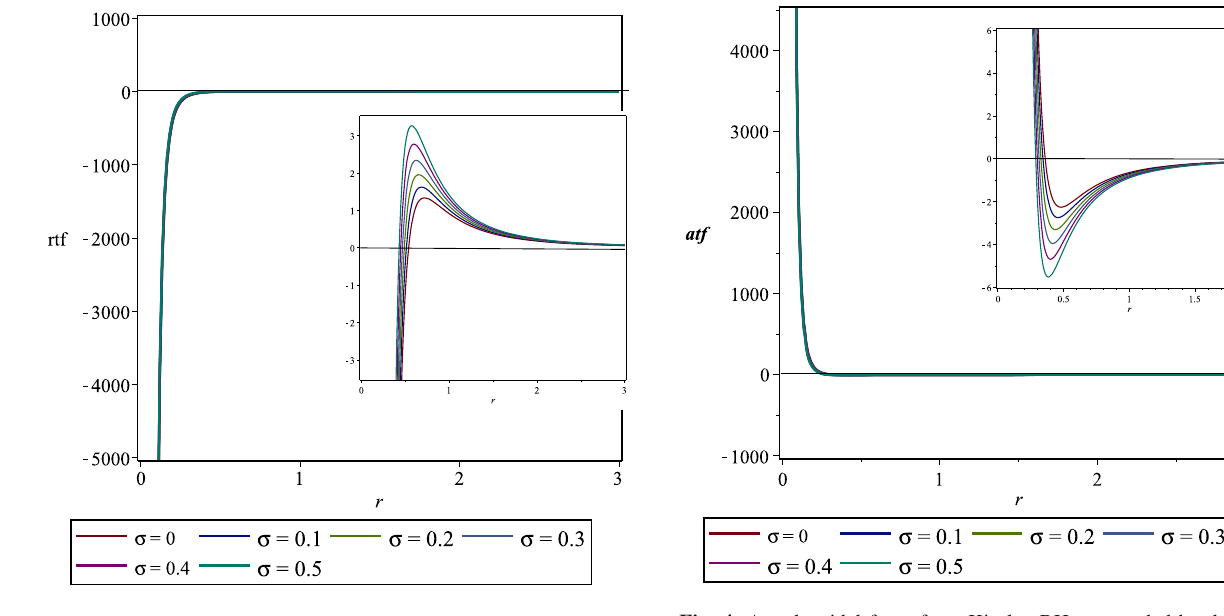
4 Solutions of the geodesic equations for a Kiselev BH We solve the geodesic deviation Eqs. (19) and (20) and find the geodesic deviation vectors as functions of r for radially free-falling geodesics. Equations (19) and (20) along